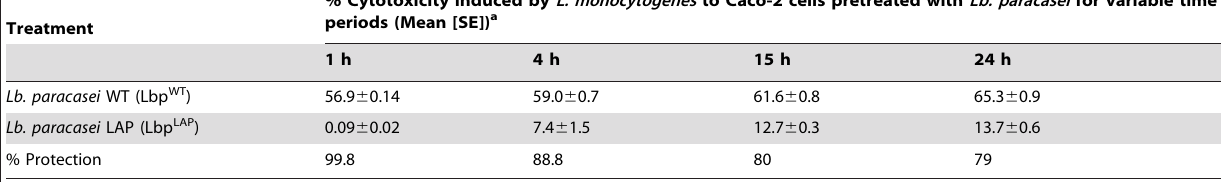
a Lb. paracasei cultures were added to Caco-2 cells at a multiplicity of exposure (MOE) of 10:1 for 1, 4, 15, and 24 h before infection with L. monocytogenes (MOI of 10:1) for 1 h. Cytotoxicity value for L. monocytogenes alone was 66.21 6 3.1. Values are averages of three experiments analyzed in triplicate and are significantly different between Lbp WT and Lbp LAP at all time points ( P , 0.05).